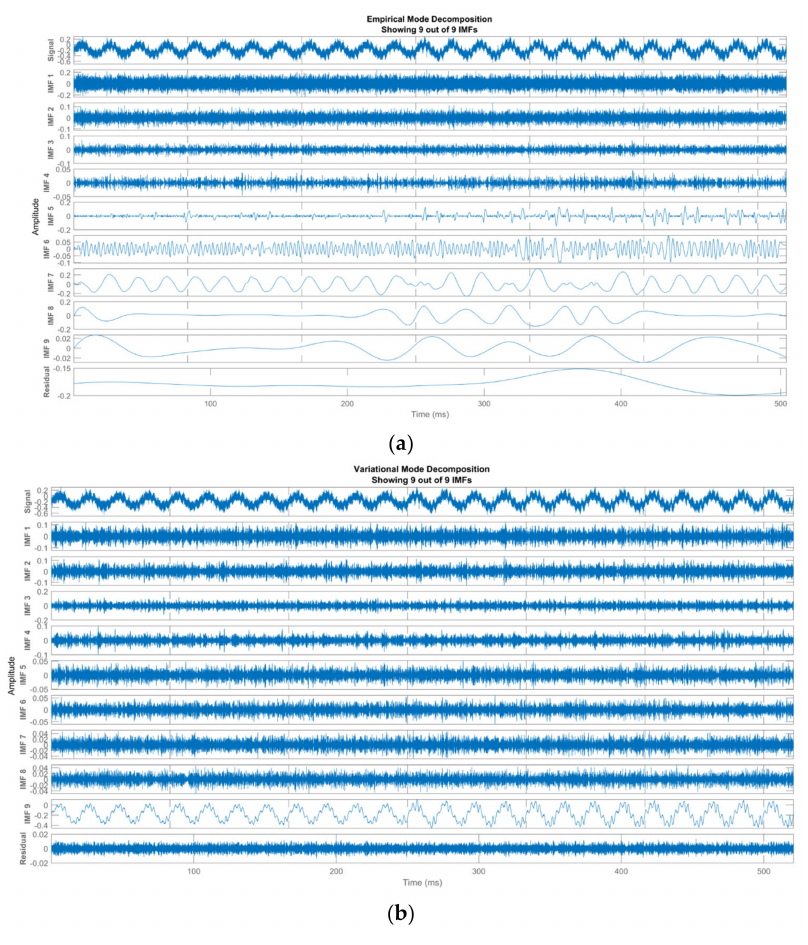
Figure 12. EMD ( a ) and VMD ( b ) decomposition of mineral oil current signal under VDE electrode arrangement (d = 1 mm).